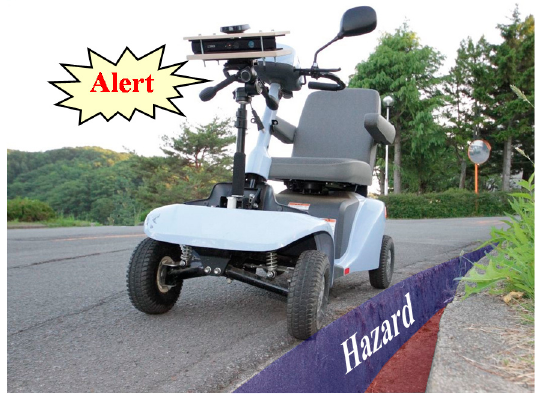
Figure 2. Image of the system.